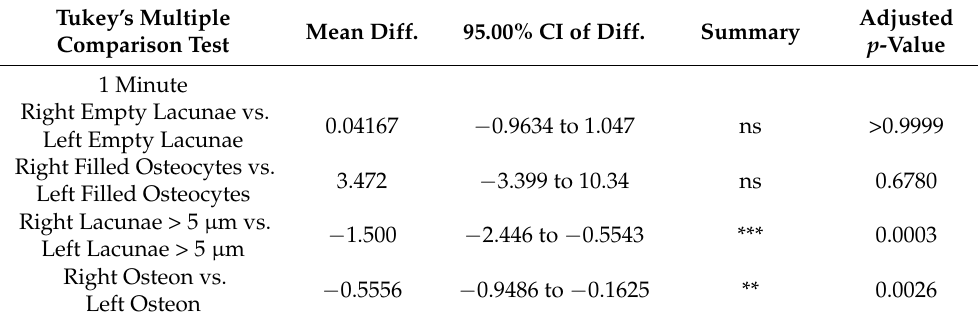
Figure 9. Left and right 1 min implant inter-group comparison graph. Table 7. Left and right 1 min implant inter-group comparison table.